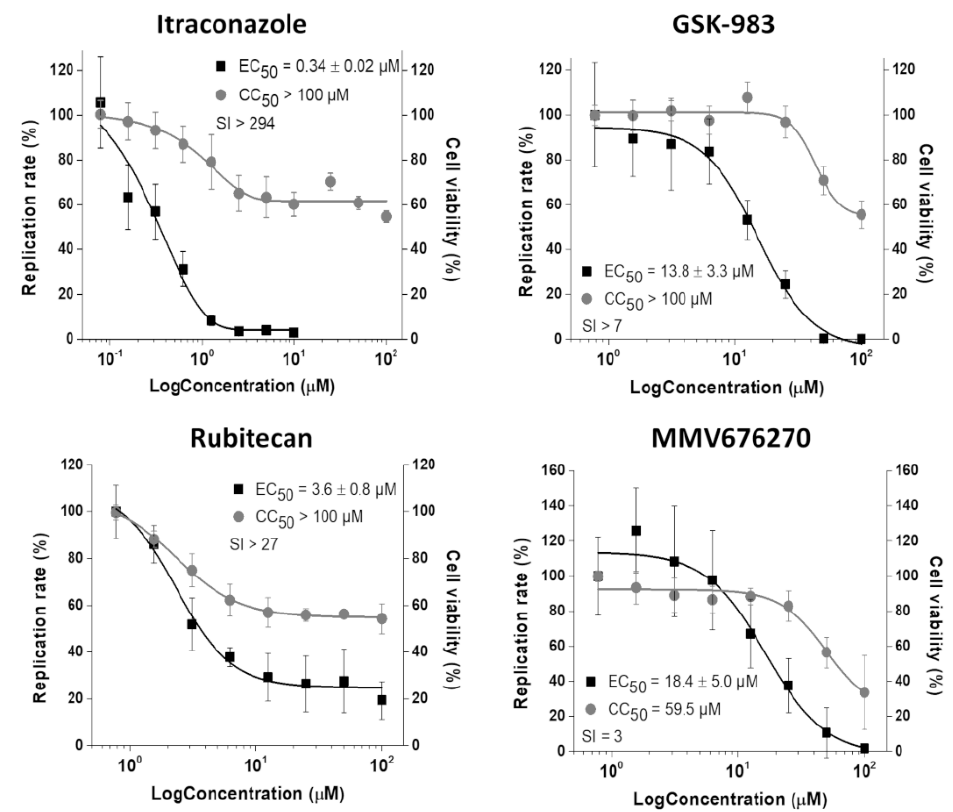
Figure 4. Inhibition of CHIKV- nanoluc infection in vitro. Concentration–response curves of selected compounds showing the relative replication rate (y-axis) over the compound concentration in log scale (x-axis). Average results of three independent experiments, each measured in triplicates, are shown, and error bars represent standard deviations.